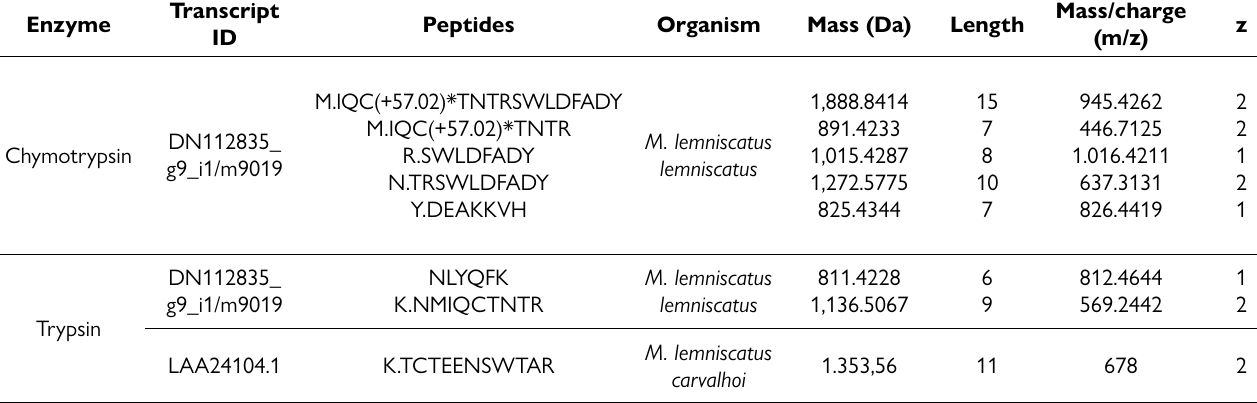
Table 1. List of proteins identified in β–micrustoxin by proteomic analysis against Micrurus protein database.